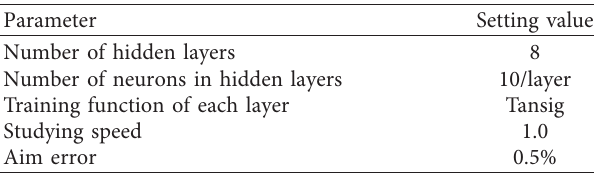
Table 1: Parameter settings of